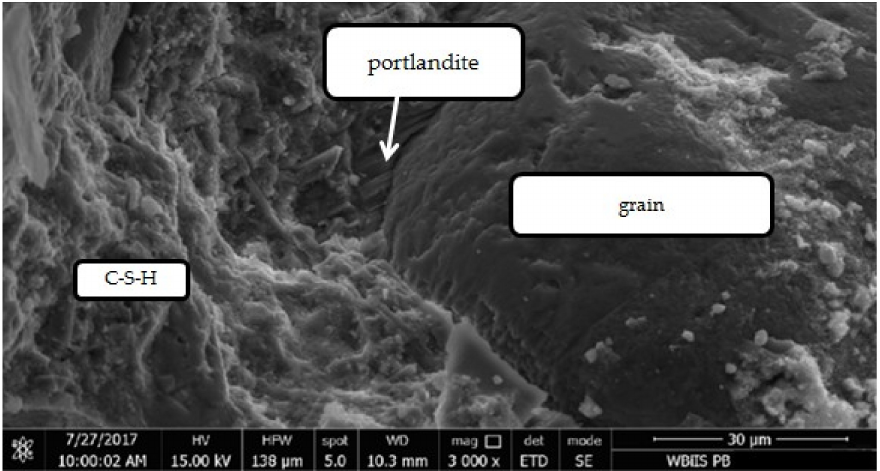
Figure 21. Contact zone between recycled aggregate without thermo-mechanical treatment and cement paste.